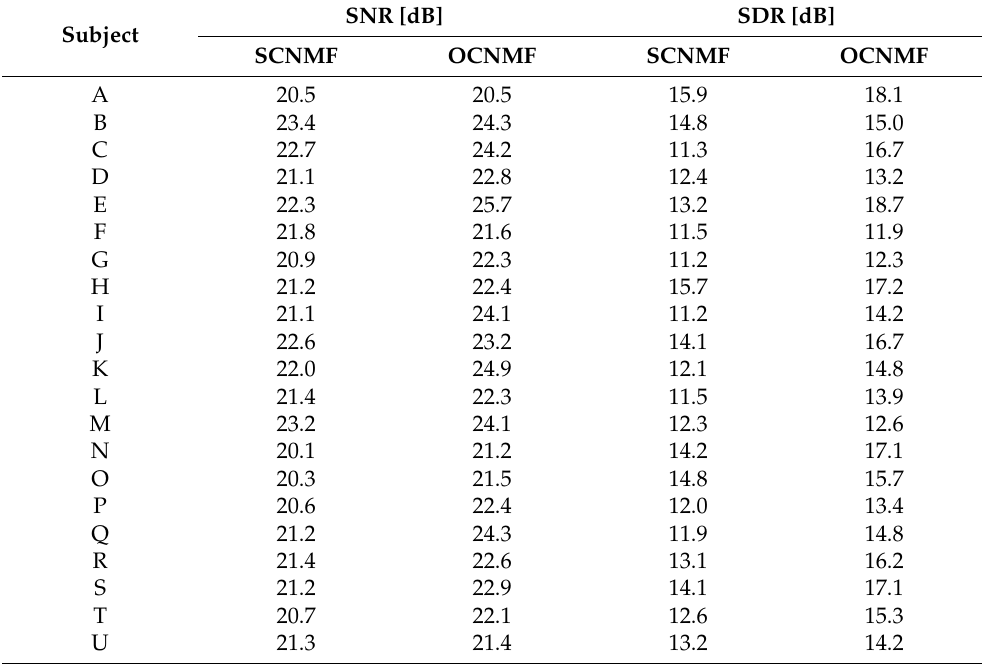
Table A1. SNR and SDR for each subject in the case of sine wave